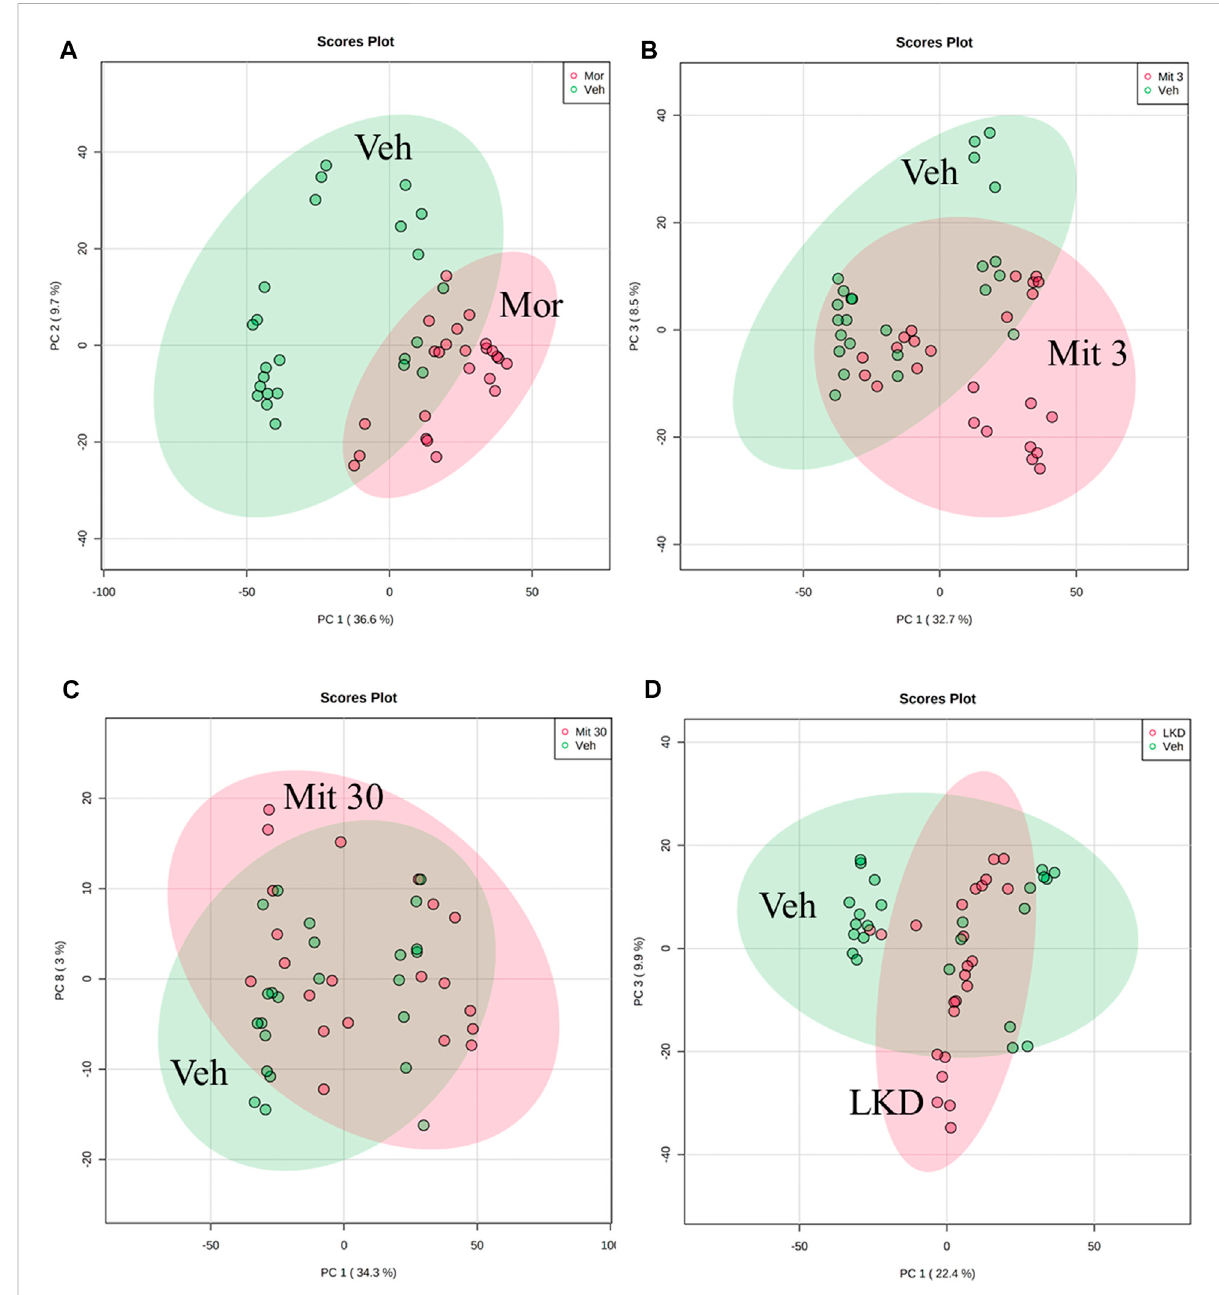
FIGURE 6 PCA of the metabolite pro fi les of adolescent rats ’ brain samples for the treatment effects of morphine, mitragynine (3 or 30 mg/kg), and LKD versus vehicle. The metabolite pro fi les for animals treated with (A) morphine 5 mg/kg and vehicle show low similarity; (B) mitragynine 3 mg/kg and vehicle show low similarity; (C) mitragynine 30 mg/kg and vehicle show high similarity; (D) LKD and vehicle show low